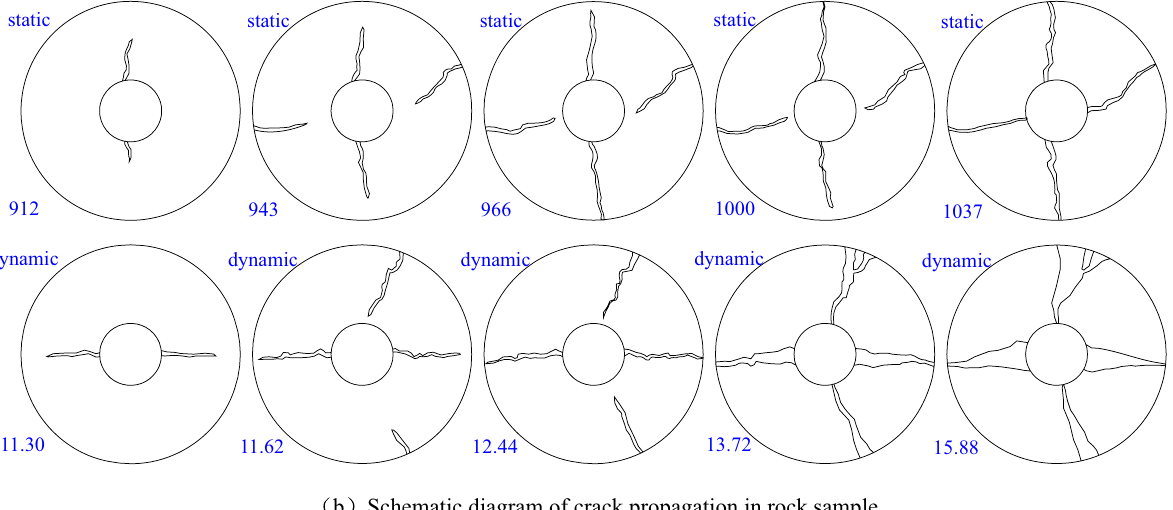
b Schematic diagram of crack propagation in rock sample